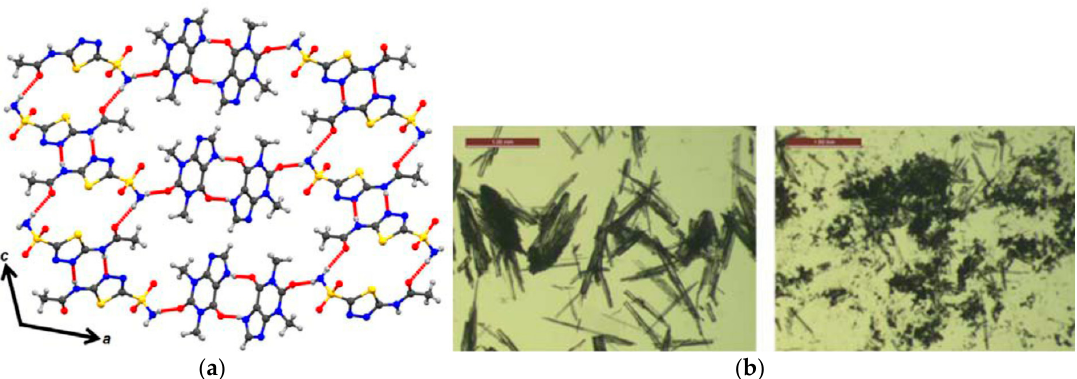
Figure 41. ( a ) Hydrogen bond interaction present in theophylline–acetazolamide cocrystal structure.